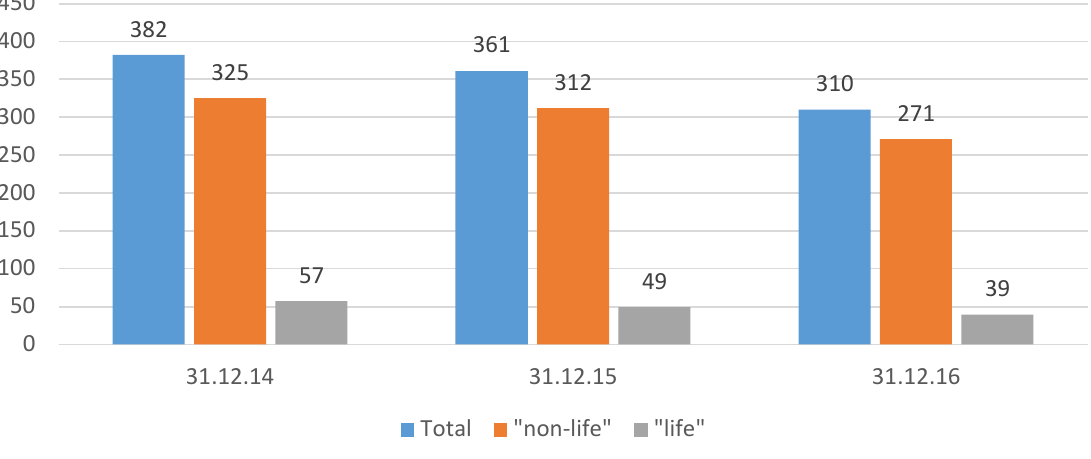
Figure 1. Diagram of the dynamics of number of insurance Table 1. Concentration of the life insurance market in Ukraine as of January 1, 2017